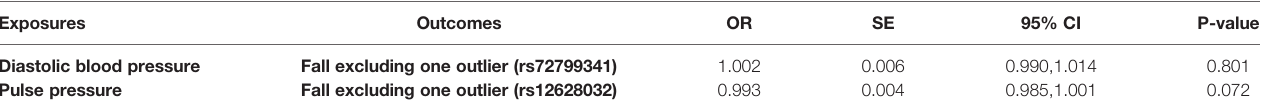
TABLE 2 | Mendelian randomization estimates between blood pressure and outcomes after excluding outliers detected by MR-PRESSO. Exposures